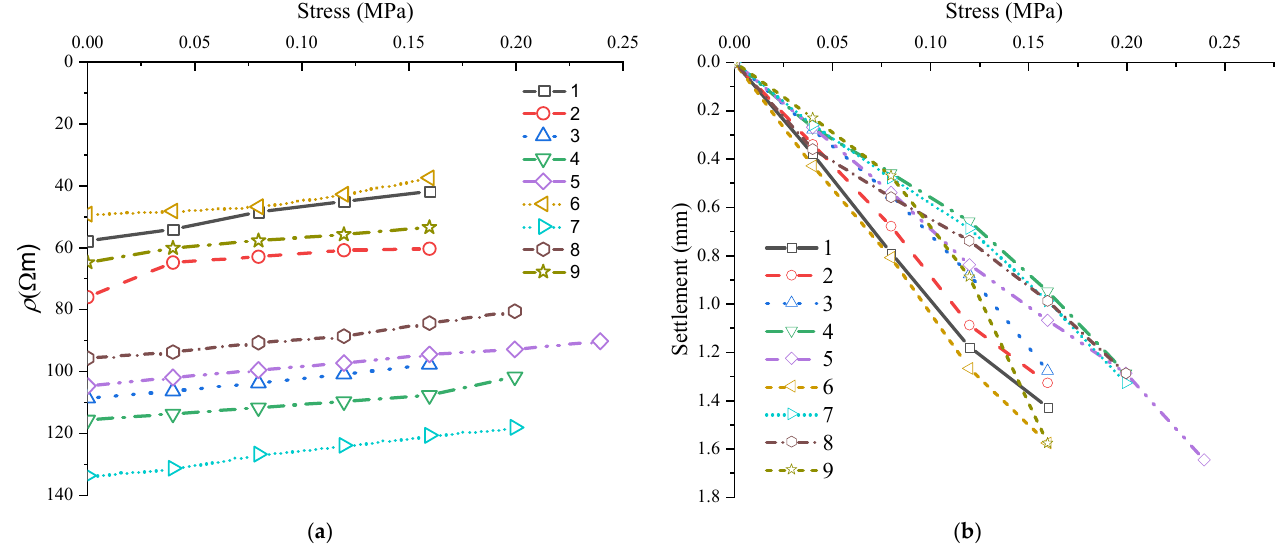
Figure 6. Resistivity plate loading test results ( a ) typical of stress- and temperature-corrected apparent resistivity curves from the concurrent resistivity subgrade reaction modulus test and ( b ) typical of the stress strain curves.